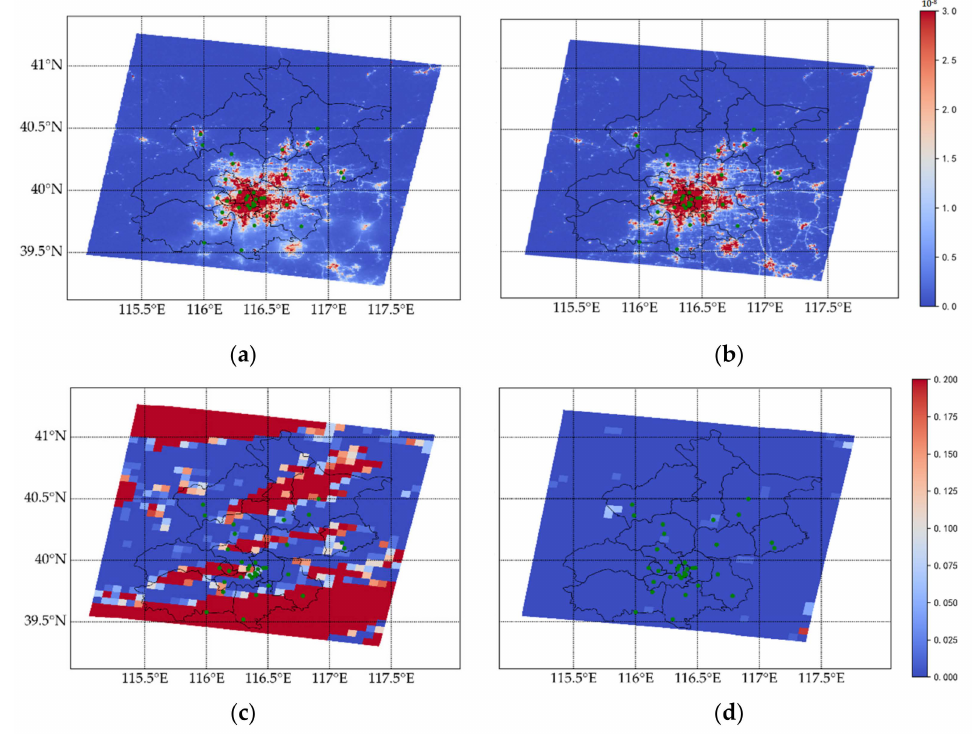
Figure 2. Images of VIIRS for Beijing: ( a , b ) DNB radiance at 17:44 on 3 January 2019 and 17:36 on 13 December 2018, respectively; solid circles denote 34 PM 2.5 monitoring sites. For ( a ), the VZA, LZA, and daily PM 2.5 were 34.33 ◦ , 133.77 ◦ , and 18 µ g/m 3 , respectively; the set of these data for ( b ) were (41.45 ◦ , 128.16 ◦ , 48 µ g/m 3 ). ( c , d ) The VCCLO corresponding to ( a , b